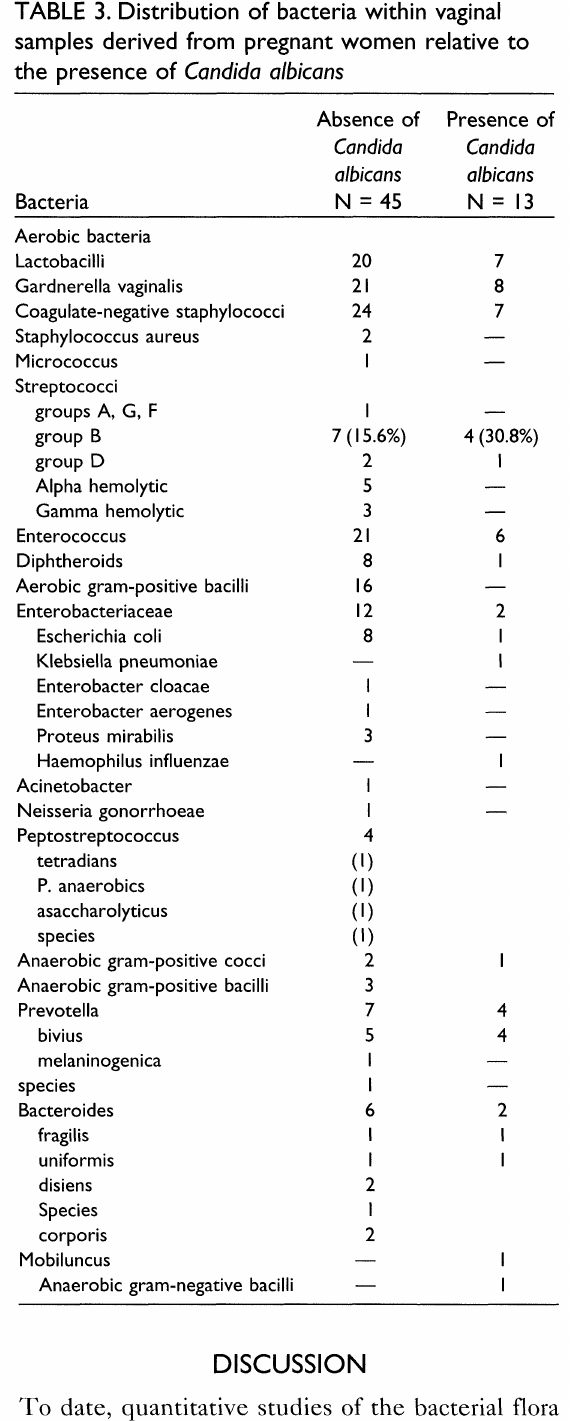
TABLE 3. Distribution of bacteria within vaginal samples derived from pregnant women relative to the presence of Candida